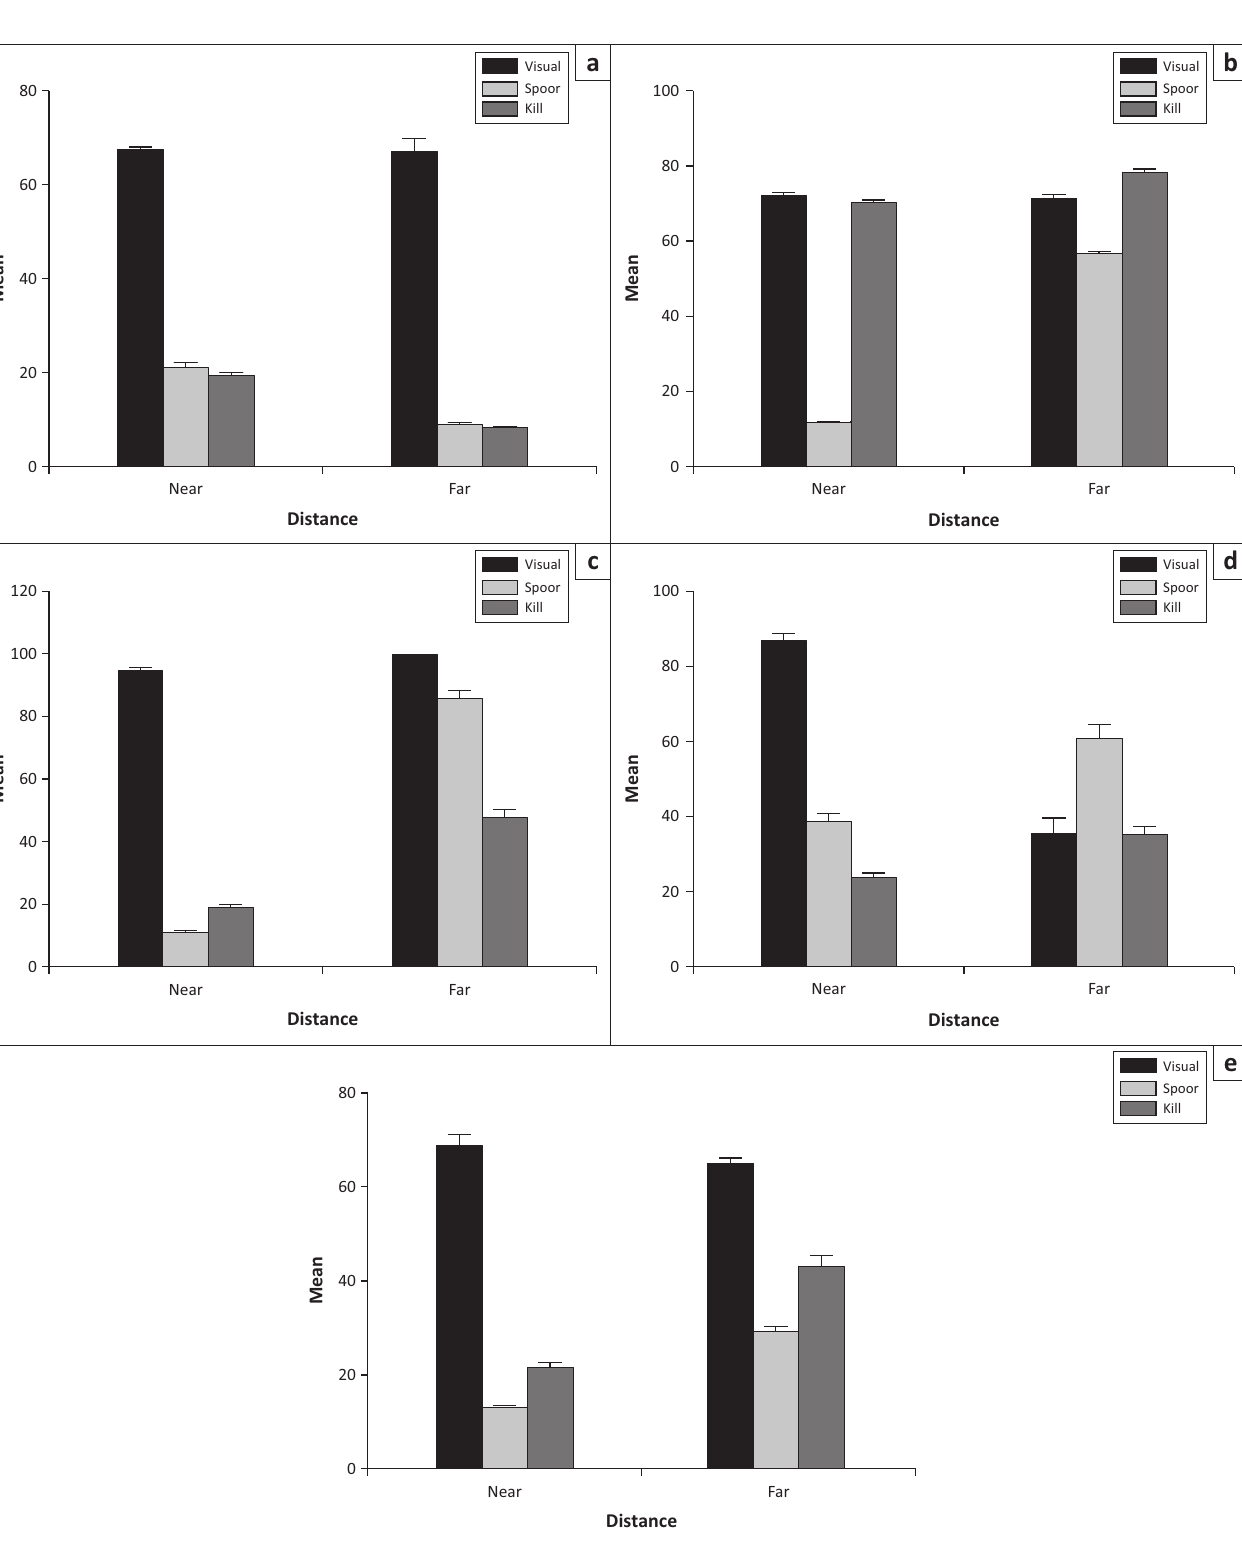
FIGURE 5: Percentage of herders who identified carnivore species correctly from cards. (a) Cheetah, (b) leopard, (c) lion, (d) spotted hyena and (e) wild